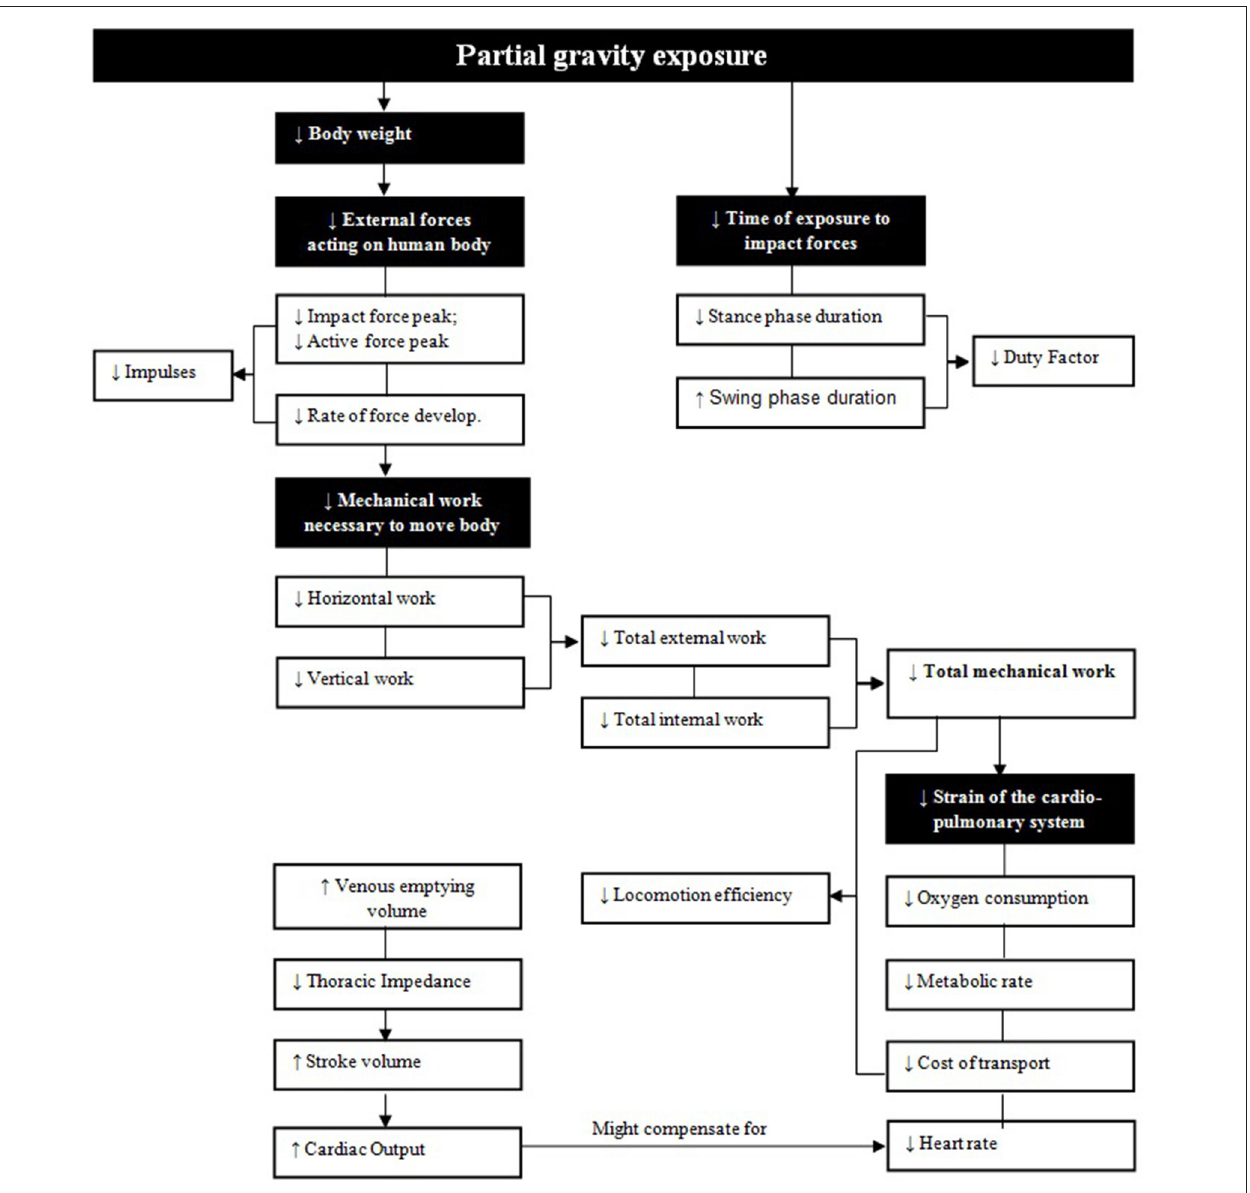
FIGURE 10 | Interaction of cardiopulmonary and biomechanical parameters. Black boxes represent physiological main factors of exposure to partial gravity while in the white boxes underlying outcome parameters are presented.